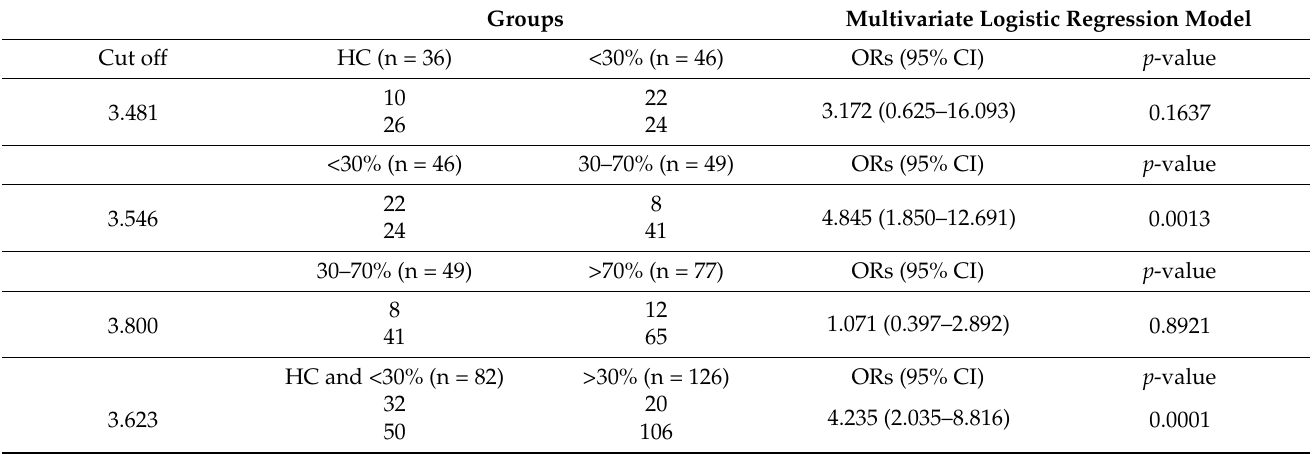
Table 3. Association of AACT among HC and CAD patients with stenosis rates of < 30%, 30–70%, and >70%.